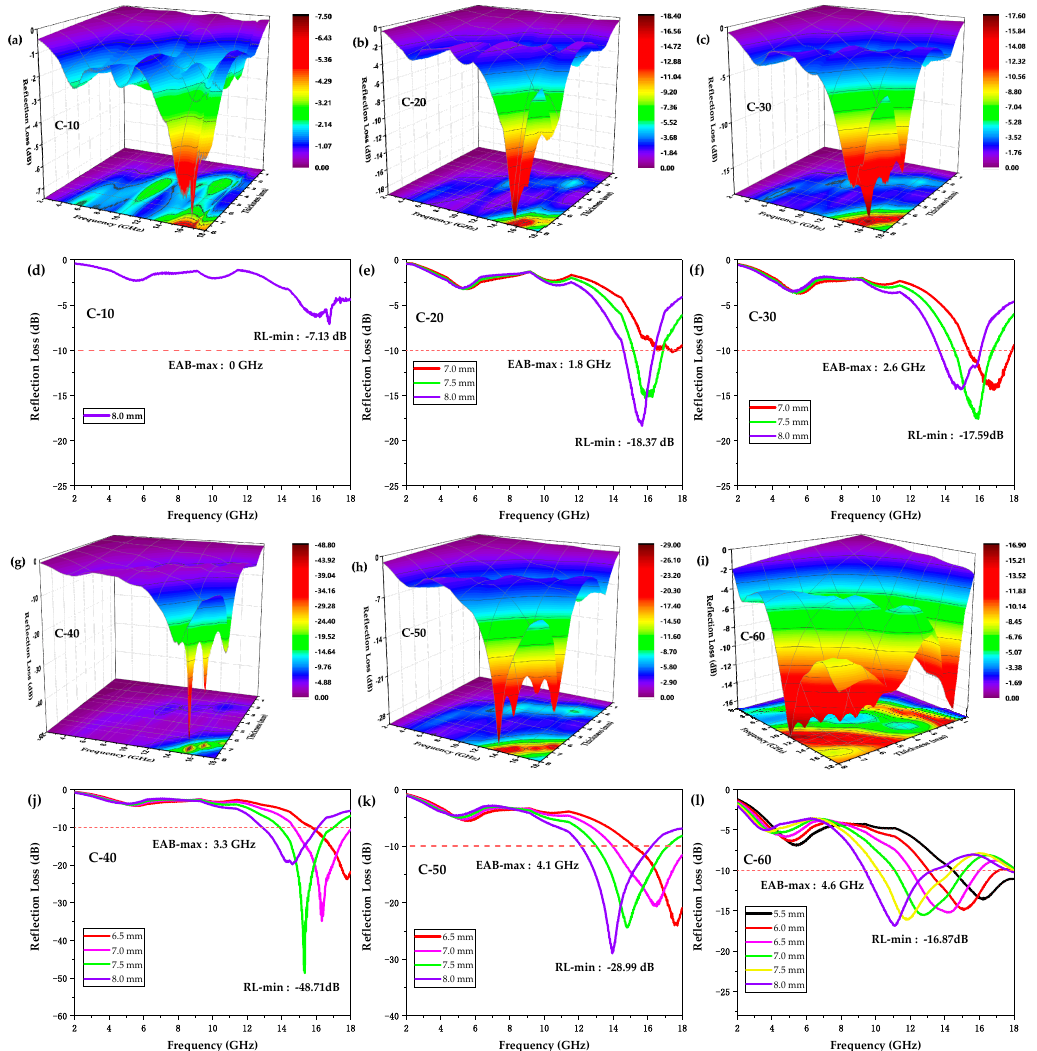
Figure 2. 3D theoretically calculated reflection loss (RL) spectra of CIP / ABS composites with varying CIP contents when the thickness increased from 0.5 mm to 8 mm, and the corresponding 2D RL plots. ( a , d ): sample C-10. ( b , e ): sample C-20. ( c , f ): sample C-30. ( g , j ): sample C-40. ( h , k ): sample C-50. ( i ) and (l): sample